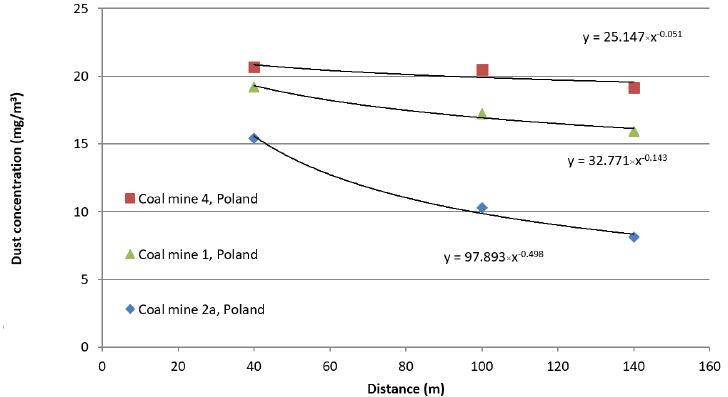
Figure 12. Momentary concentration of PM10 dust, obtained from three Pł-2 dust meters—coal face in one of the mines.